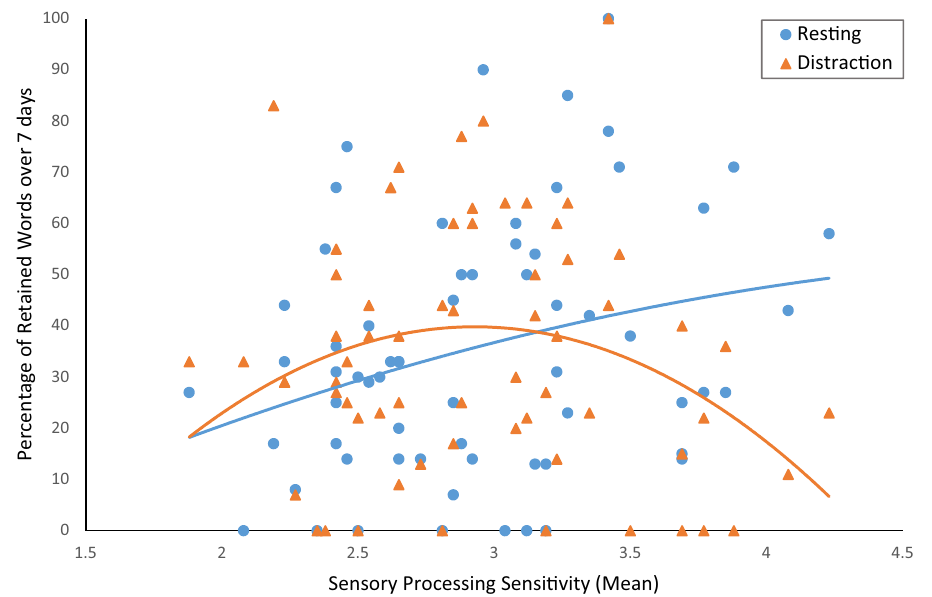
Figure 2. Scatterplots showing the percentage of correctly retained words over the retention interval from immediate to delayed recall after 7 days as a second degree polynomial function of SPS, plotted separately for the wakeful resting (blue circles) and distraction (orange triangles) post-encoding